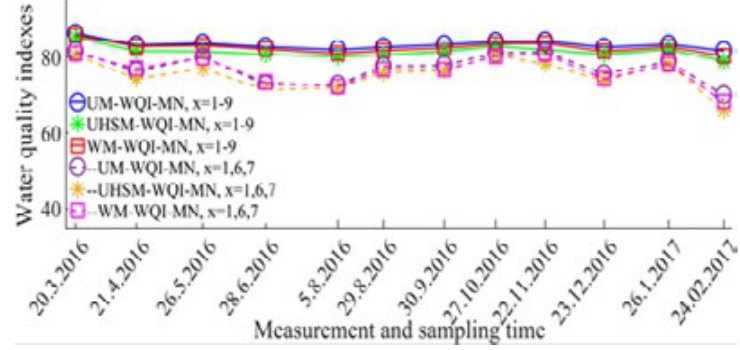
Fig. 7: Change of water quality indices with three and nine parameters with respect to time for station FM